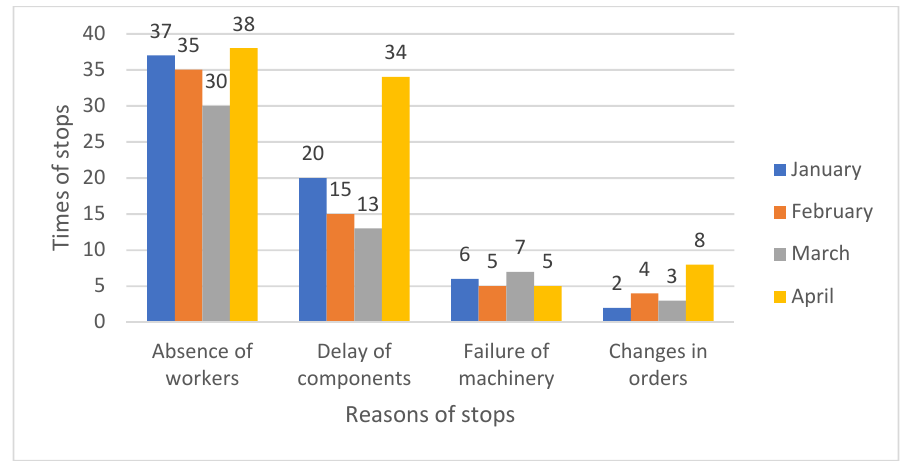
Figure 1. Observation results: issues of production stops.